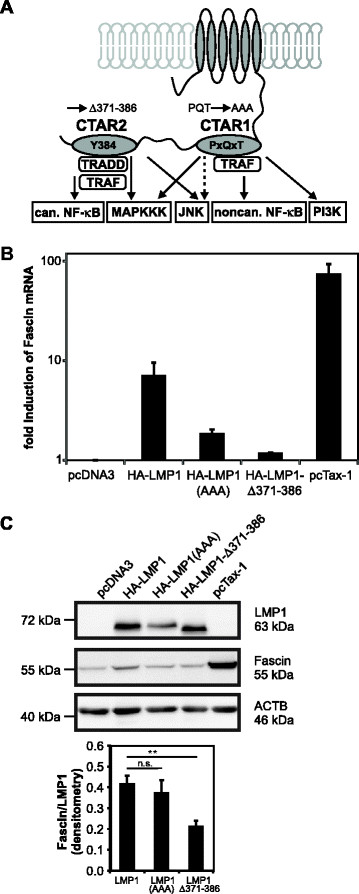
CTAR2 is the major site of LMP1-mediated Fascin induction. (A) Scheme of LMP1 and its signaling domains, the C-terminal activating regions 1 (CTAR1; aa 194–231) and 2 (CTAR2; aa 351–386). Mutations of the P(204)xQxT consensus motif to AxAxA in CTAR1 and deletion of aa 371–386 in CTAR2 are indicated. Signaling pathways induced by LMP1 are shown in rectangular boxes, adaptor molecules in rounded boxes. can. indicates canonical; noncan., noncanonical. (B) qPCR of Fascin transcripts 48 h after transfection of Jurkat cells with wt-LMP1 (20 μg pCMV-HA-LMP1), LMP1 mutants (40 μg pCMV-HA-LMP1(AAA), 20 μg of pCMV-HA-LMP1-Δ371-386) and HTLV-1/Tax (40 μg pcTax-1) in comparison to mock-transfected cells (100 μg pcDNA3). Total transfected DNA was adjusted to 100 μg with pcDNA3. Copy numbers were normalized to those of ACTB and on mock-transfected cells. Mean values +/− standard error (SE) are given. (C) Detection of Fascin and LMP1 by immunoblot after transient transfection of Jurkat cells with the constructs described in (B). Fascin expression was quantitatively evaluated by densitometry and normalized on LMP1 protein expression. The mean of three independent experiments +/−SE is shown. **indicates P < 0.01. n.s., not significant.